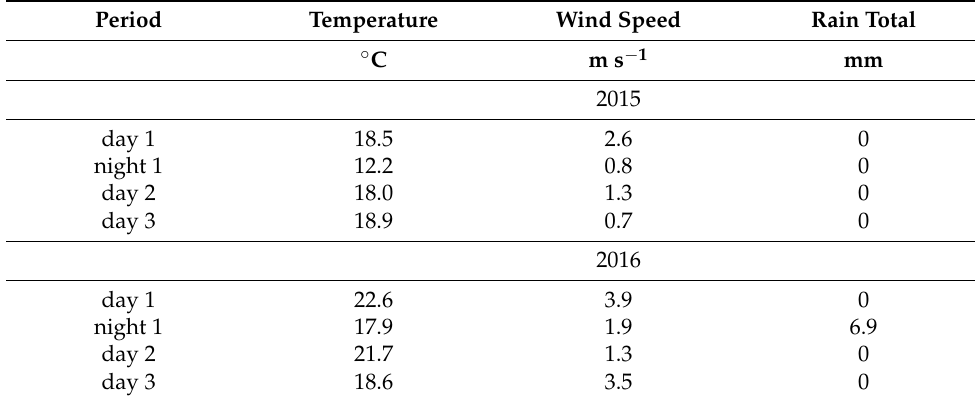
Table 3. Weather during ammonia flux sampling in 2015 and